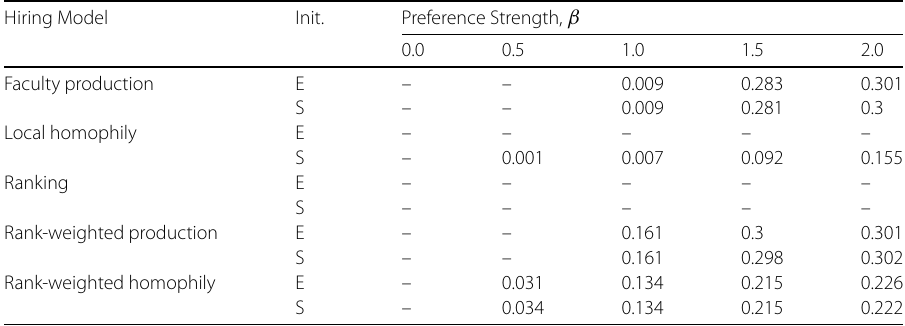
Table S4 Best-fit values of the random hiring parameter p for the History faculty hiring network. Each entry in the table presents the value of p that minimized the distance between modeled networks and empirical networks for values of preference strength β , initializations (E, Egalitarian; S, Skewed) and hiring models, as shown. For combinations which were unable to plausibly reproduce the properties of empirical networks ( D > 0.1, see Methods), no value of p is given Hiring Model